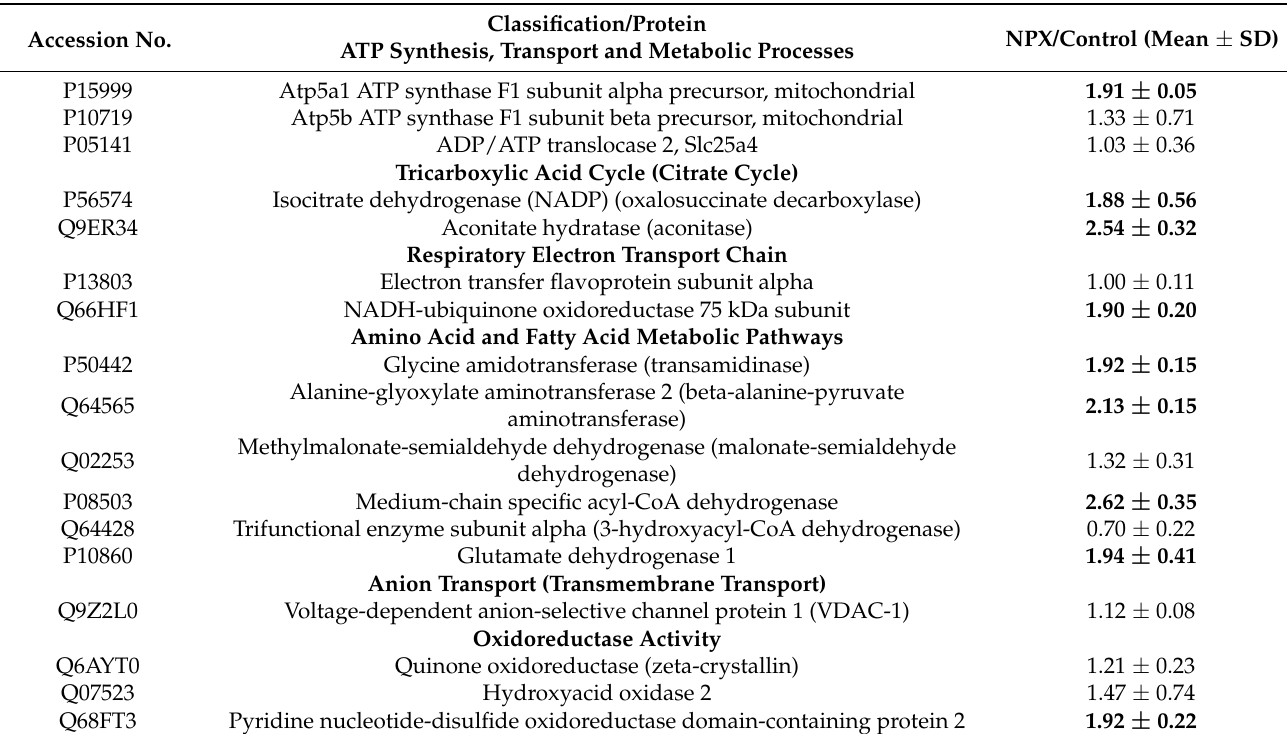
Table 1. Summary of selected proteomics data of mitochondria from control and NPX rat kidneys using iTRAQ TM labeling and liquid chromatography/mass spectrometry/mass spectrometry (LC/MS/MS) analysis. Results are the ratios of protein abundance relative to a control and are means ± SD of 5 sample LC/MS/MS runs. Fold changes in ratios of NPX: control ≥ 1.50 are highlighted in